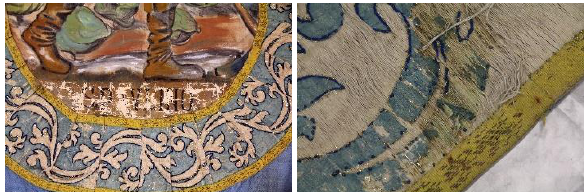
Figure 10 – Examples of tears on fabric elements on banners S. Paulino (left) and S. José (right)